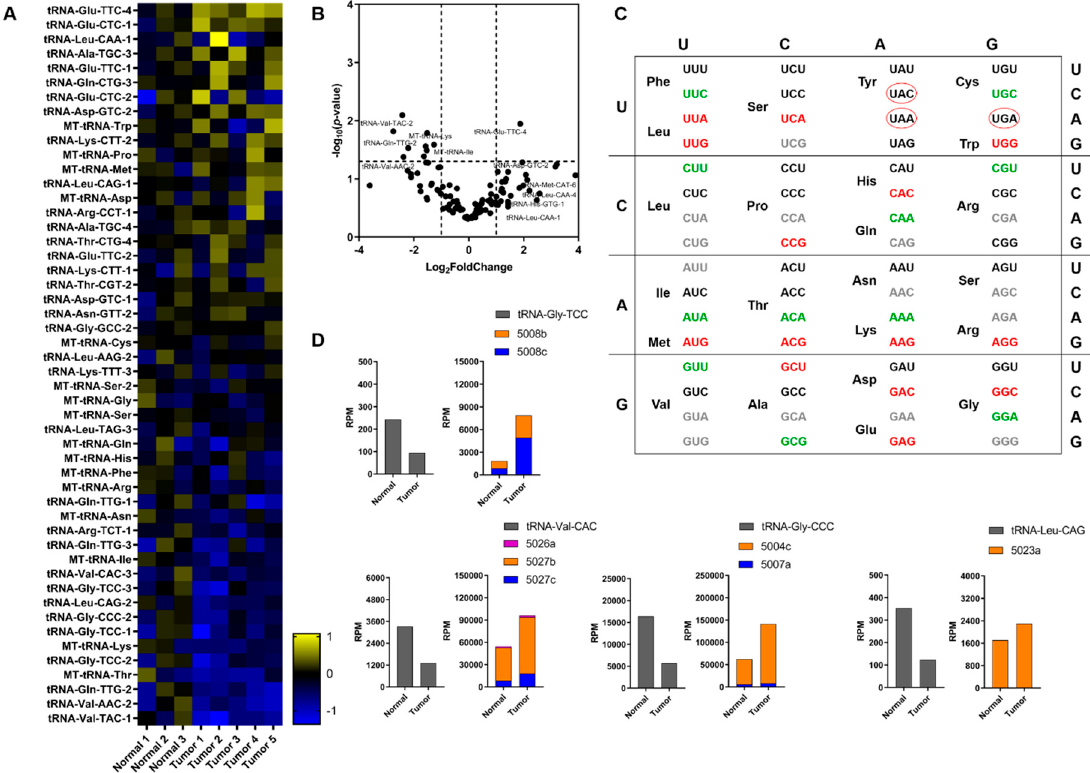
Figure 3. Expression profile of tRNAs. ( A ) Heatmap of the most altered tRNAs. The analysis was performed in 8 samples (5 tumor and 3 normal tissue specimens, Table S7). The heatmap was constructed based on the log2 fold change values and normal samples are shown after normalization of individual samples versus the mean of RPM. Yellow and blue colors indicate up- and down- regulation, respectively. ( B ) Volcano plot of the detected tRNAs assessed in the present analysis. ( C ) Expression pattern of tRNAs grouped in 64 codons. Red color denotes up-regulation and green color denotes down-regulation. Grey color denotes tRNAs that remain relatively unaltered and black color denotes tRNAs that were not identified in the present analysis. Stop codons are indicated in black color and red circles. ( D ) Representative downregulated tRNAs in tumor specimens and their reciprocal correlation with tRNA fragments that derive from those tRNAs. The levels of important genes involved in tRNA transcription, maturation, transport and aminoacylation in the above-mentioned processes were measured and we observed upregulation of SSB which encodes the La scaffold protein that facilitates proper folding of pre-tRNAs. In addition, the expression of almost all genes encoding for the protein subunits of RNase P (the ubiquitous ribonuclease responsible for 5 ′ maturation of pre-tRNAs) were also found upregulated. Among those genes, RPP14 , RPP20 , RPP30 and RPP38 exhibited the most significant upregulation (Figure S3A). These results could be related with the demand of cancer cells for increased mature tRNA production to serve the elevated translation rates. In the same line, the expression of genes that encode important aminoacyl-tRNA synthetases (aaRSs) was examined. It is known that several aaRSs are correlated to angiogenesis (WARS, YARS, EPRS, RRS and IRS), immune response (YARS, KRS and RRS) and cell proliferation (KARS and MARS) [48]. In our study, we observed upregulation of MARS and EPRS and downregulation of WARS , QARS and AIMP1 (encoding for the non-enzymatic scaffold protein p43) (Figure S3B). Our analysis showed a distinct tRNA expression profile, which could contribute to mechanisms related to carcinogenesis and cancer progression and verified that several genes